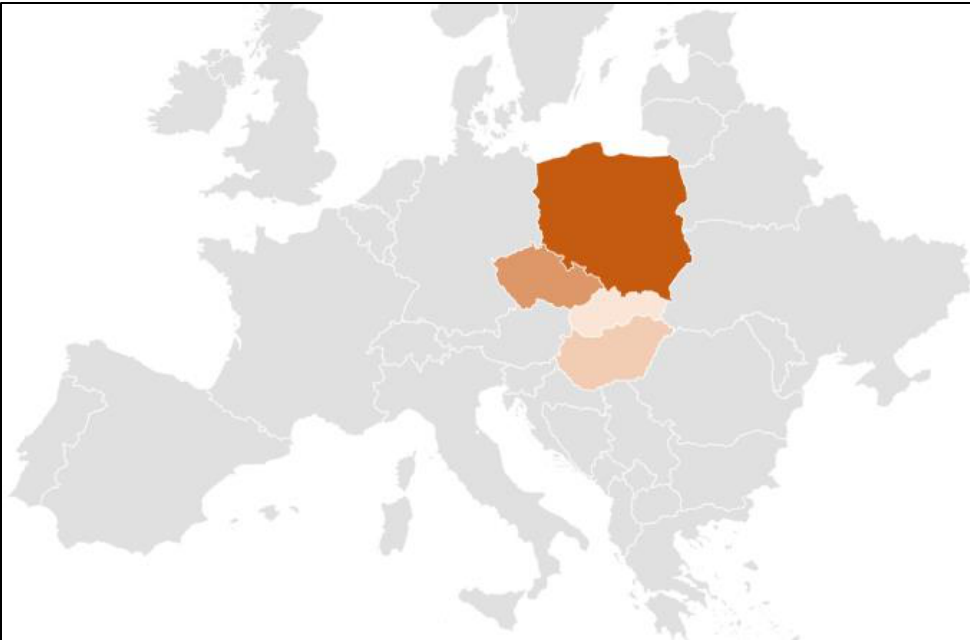
Figure 7. An overview of published articles from V4 countries on the topic Smart cities. Source: own analysis as per Web of Science (2022).